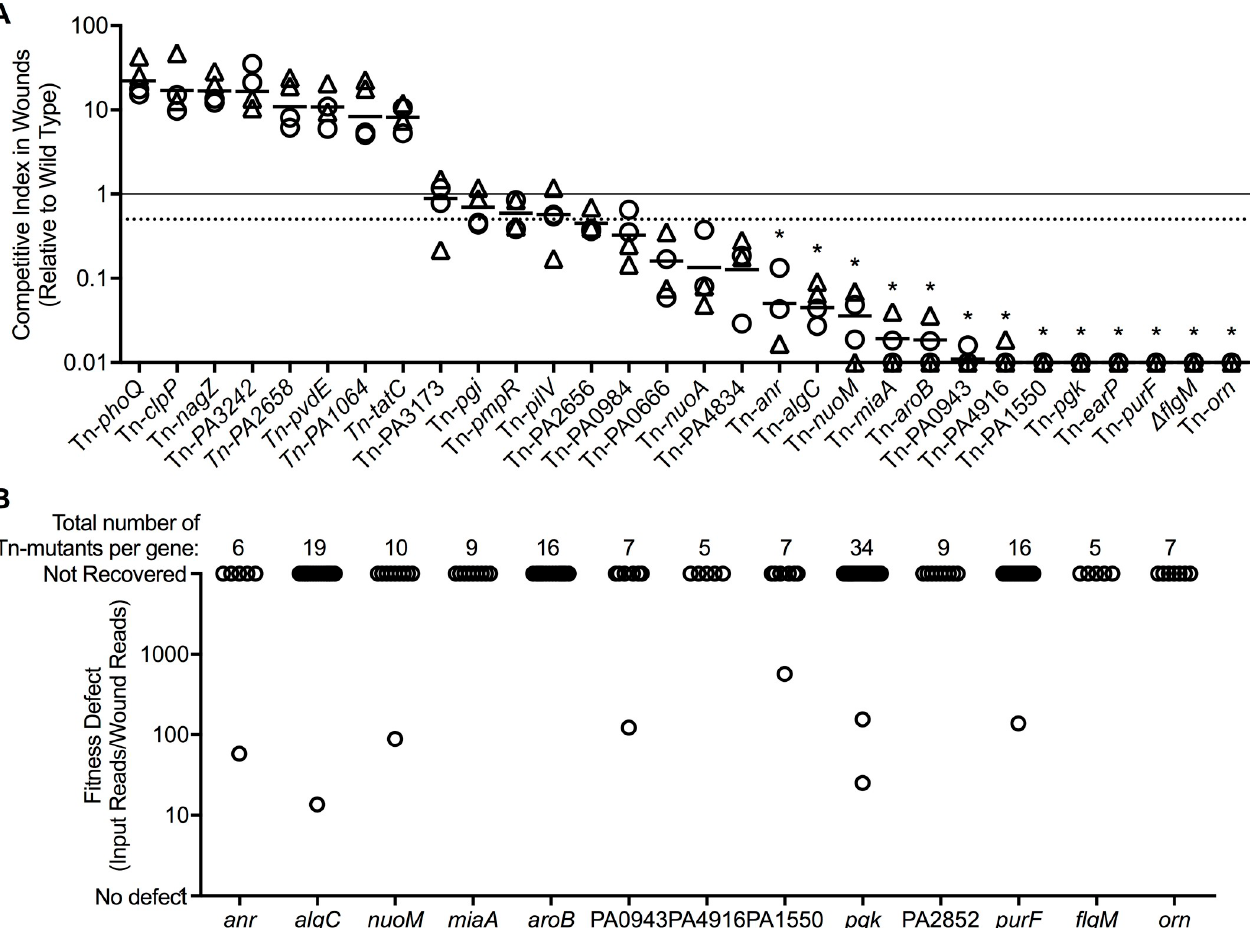
Fig 4. Confirmation of gene inactivations that compromise wound fitness. A. Mutants in 30 genes showing Tn-seq defects were tested in 1:1 competition with wild type, and mutant fitness in wound beds (triangles) or scabs (circle) was measured after five-days of infection. Dashed line indicates > two-fold defects in competition; � indicates competitive index significantly different than 1 (p < 0.01) by one sample t-test. B. Fitness of individual transposon mutants in the 13 genes whose inactivation caused > 10-fold impairments in wound fitness. Every gene verified to produce wound fitness defects was inactivated by at least five unique transposon mutants (points represent individual mutants). Almost every mutant in each gene exhibited similar fitness defects indicating that spontaneous secondary mutations were not likely responsible.